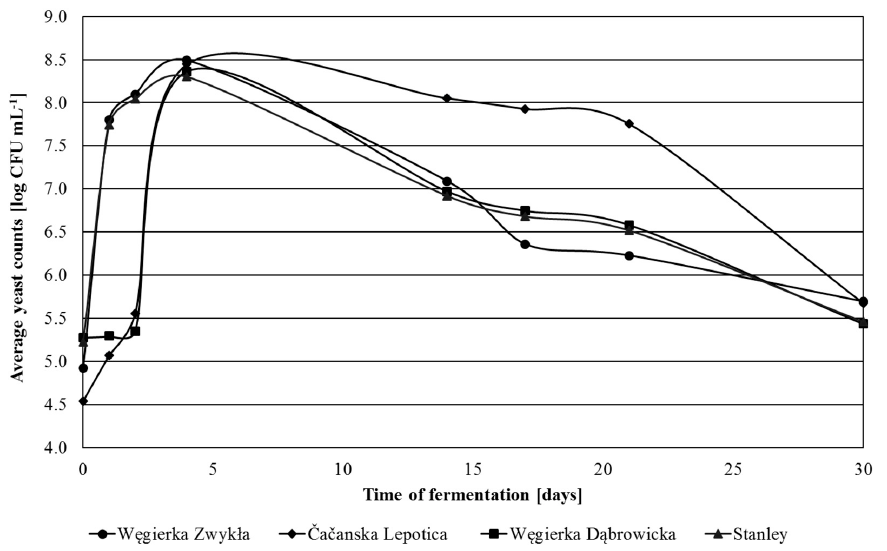
Figure 4. Total counts of yeasts 2013 season in the course of fermentation, n = 3, STD < 5%.